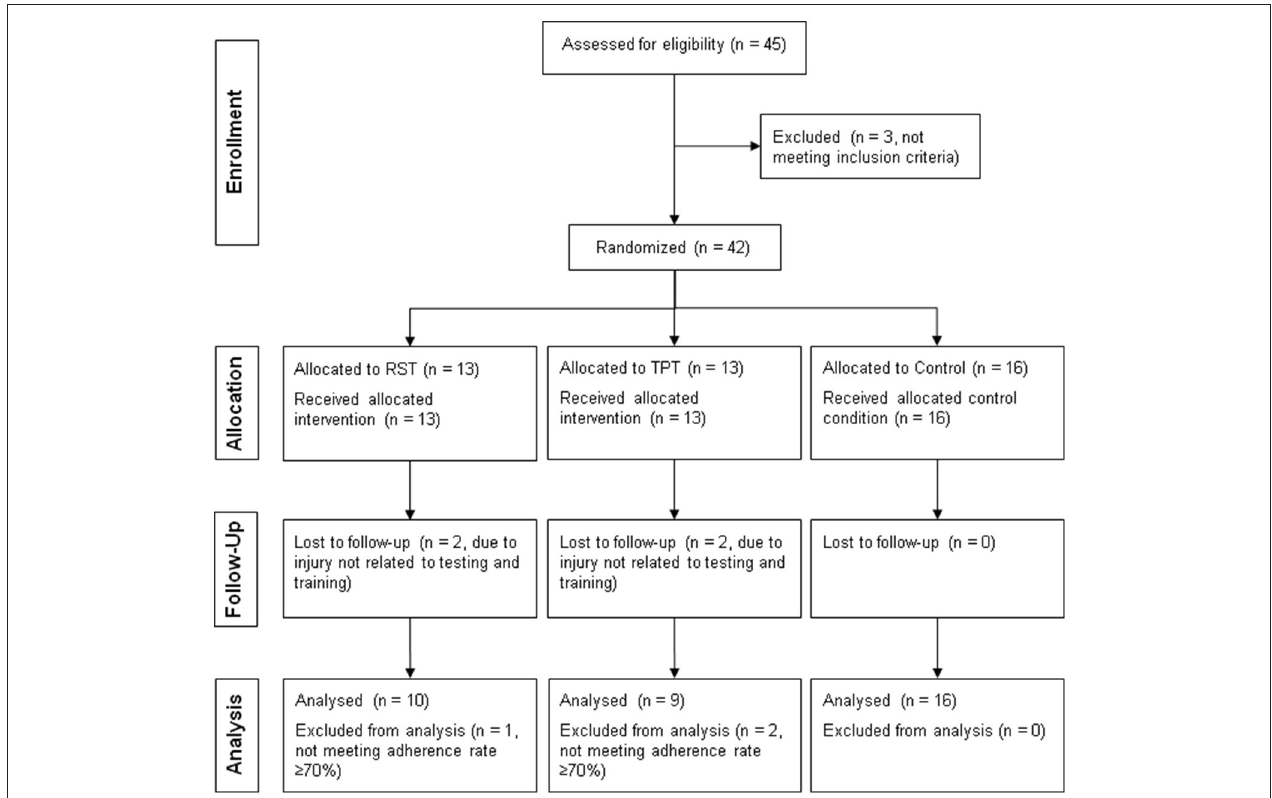
FIGURE 1 | Flowchart of the study